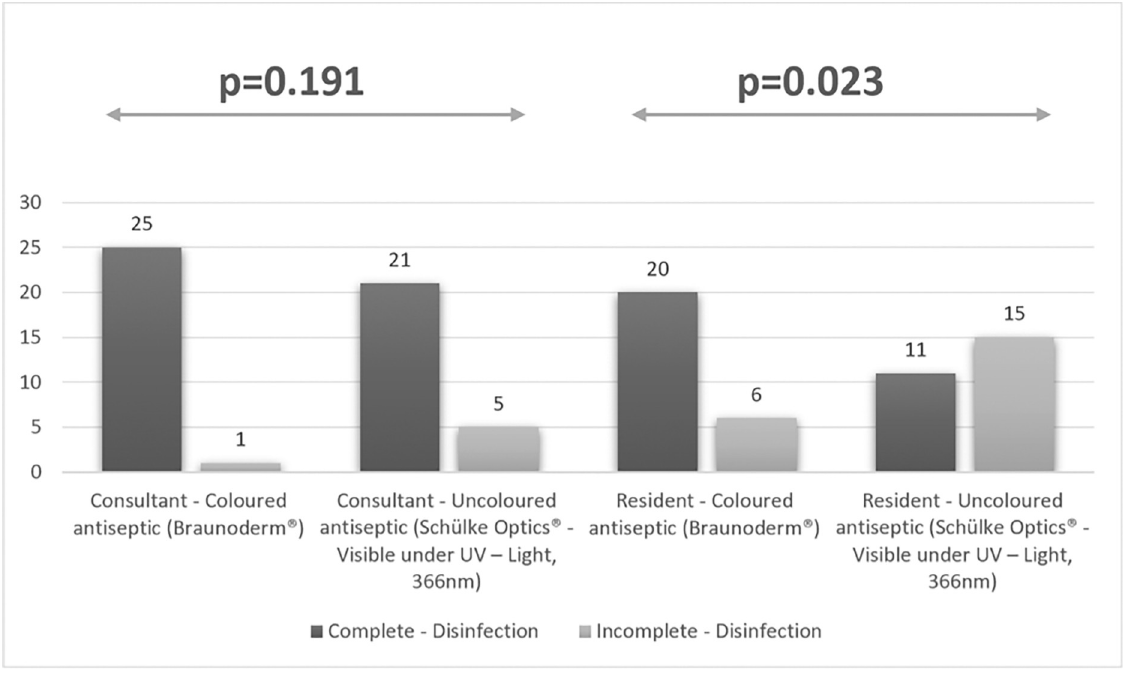
Fig 5. Comparison between consultant and resident THA skin preparation when using colored vs. colorless skin antiseptic. The total amount of uncleansed skin in square centimeters by residents using colorless vs. colored skin disinfectant was 16.10 ± 47.89 vs. 1.29 ± 3.68, (p = 0.006). In contrast, the total amount of uncleansed skin in square centimeters by consultants using colorless vs. colored skin disinfectant was 0.84 ± 1.92 vs. 0.01 ± 0.07 (p = 0.072).